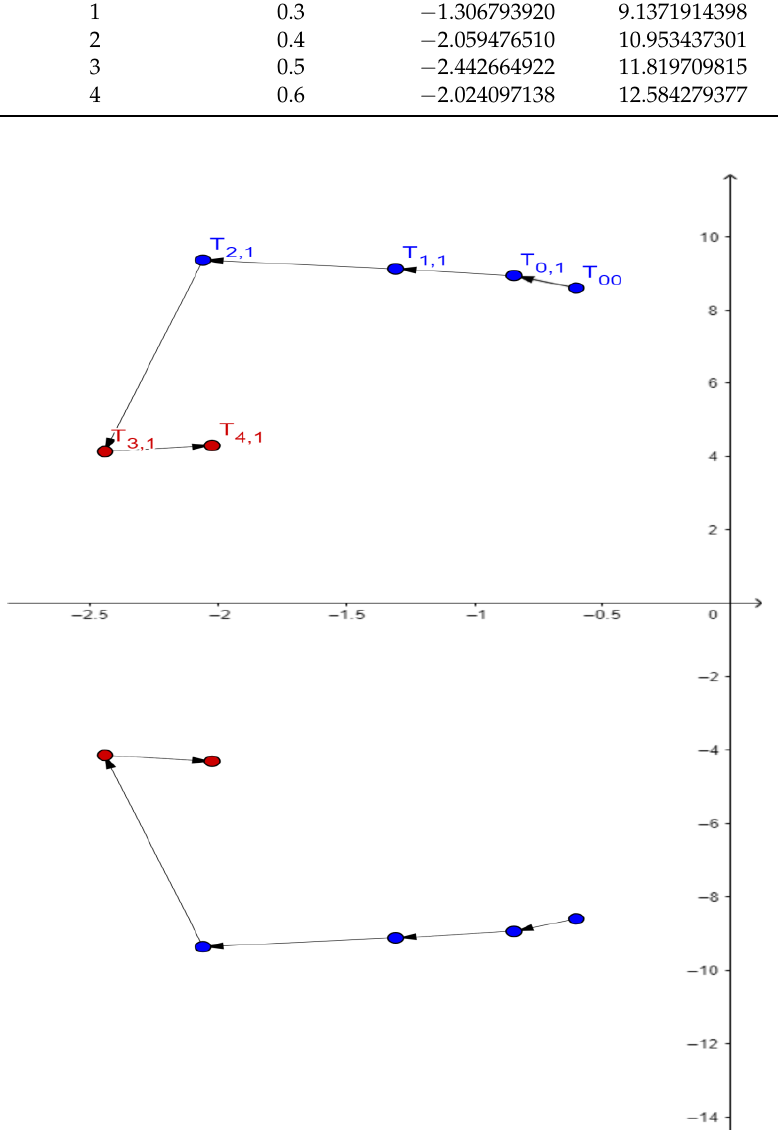
Figure 6. Dominant oscillatory pole movement in the S-plane after the PSS implementation with K = 10 and the increasing time constants from T = 0.2 s to T = 0.6 s. The observed variables in the time-domain simulations are rotor angle, speed, and active power of Gen 1 after initiating a (small) disturbance (3-phase short-circuit) on BUS 4 with the duration of 30 ms at the time instance t init = 0.1 s from the simulation begin- ning. Figure 7 shows the rotor angle response with different PSS time constant(s)- T = T i, 1 setting. As can be seen from the figure, increasing the PSS time constant(s) results in a shorter settling time and decreased overshoot and undershoot of the rotor angle during the transitional process. Similar behavior is shown by the generator speed (Figure 8) and the active power (Figure